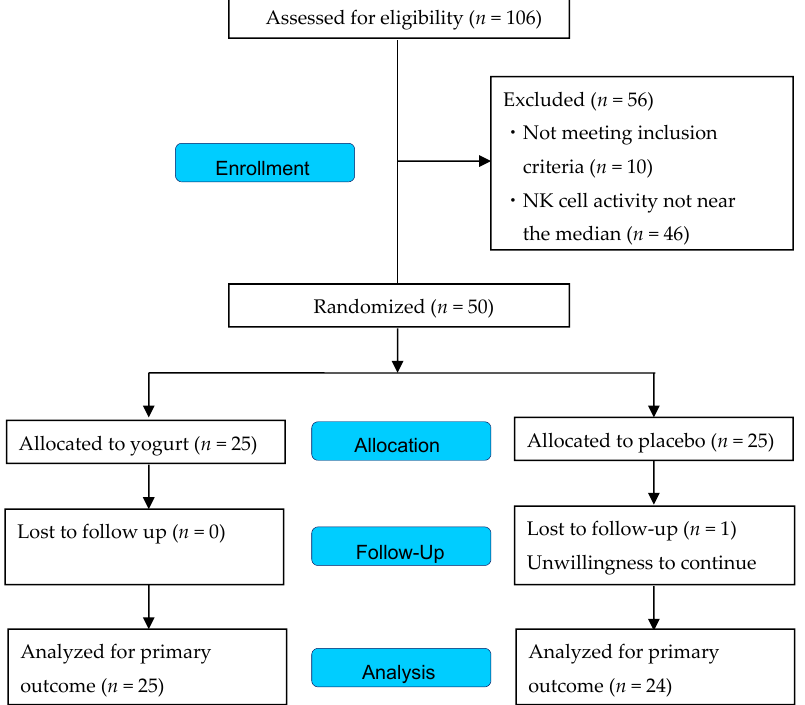
Figure 2. Study flow